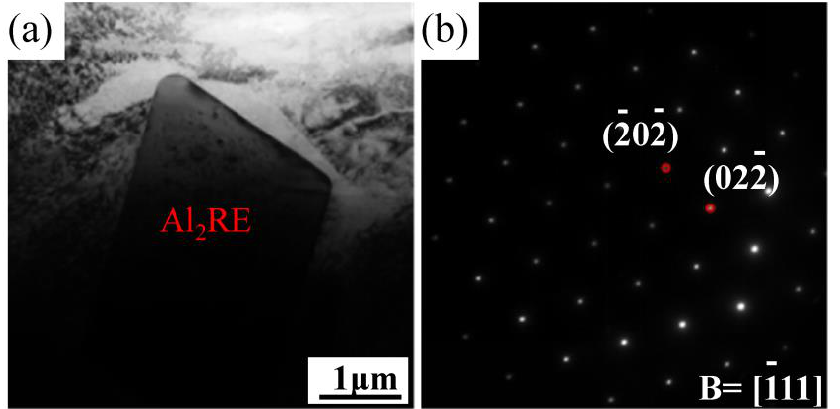
Figure 5. TEM image and SAED patterns of granular Al 2 RE phase in the Mg-3Y-4Nd-2Al alloy after solution treatment at 545 °C: ( a ) TEM image and ( b ) SAED patterns.